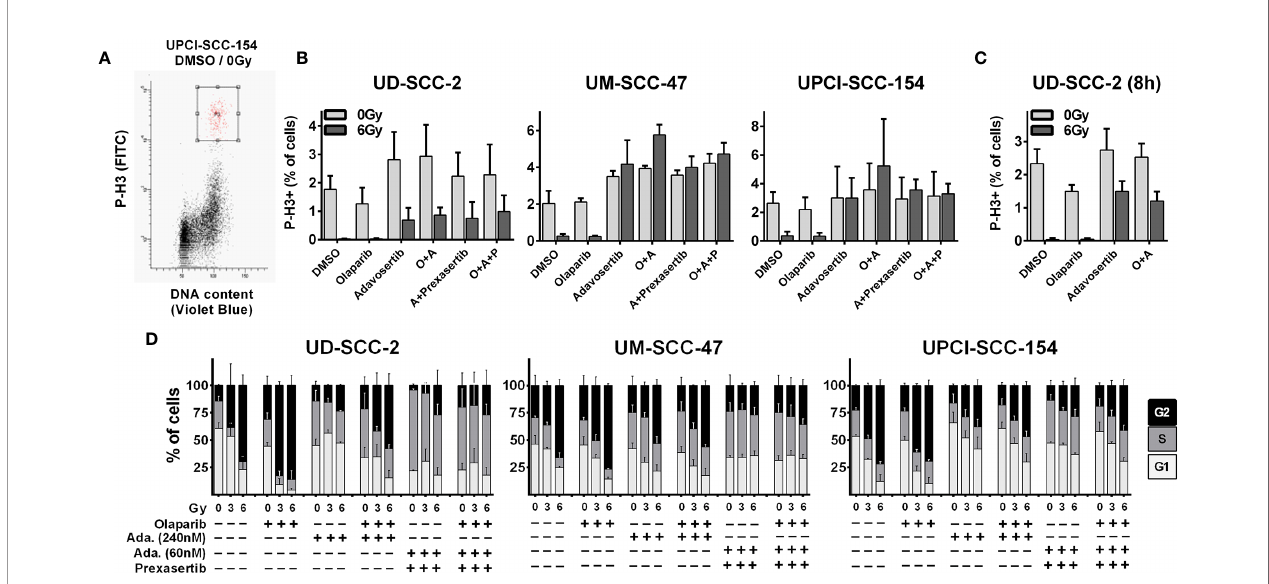
FIGURE 2 | Radiation-induced G2 arrest. (A – C) Fraction of mitotic cells. Exponentially growing cells were treated for 2 h with the inhibitors as indicated (olaparib: 1 µM; adavosertib: 240 nM; adavosertib + prexasertib: 60 nm + 1 nM, respectively), before irradiation with 0 or 6 Gy. Five or eight hours after irradiation cells were fi xed and stained for phospho-histone H3 (P-H3+) to assess the number of mitotic cells. (A) Gating. (B) Quanti fi cation of the mitotic fraction at 5 h after irradiation. (C) Quanti fi cation at 8 h after irradiation. (D) Long term G2 arrest. Cells were treated and irradiated as in (A – C) . Twenty-four hours after irradiation the cells were fi xed, and the cell cycle distribution was assessed by DAPI staining and fl ow